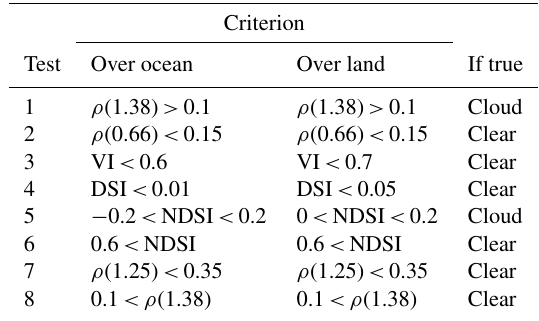
Table 1. Hyperion cloud detection algorithm (Griffin et al., 2003). We test each criterion in sequence, starting from the top, and ascribe a classification based on the first test that evaluates to